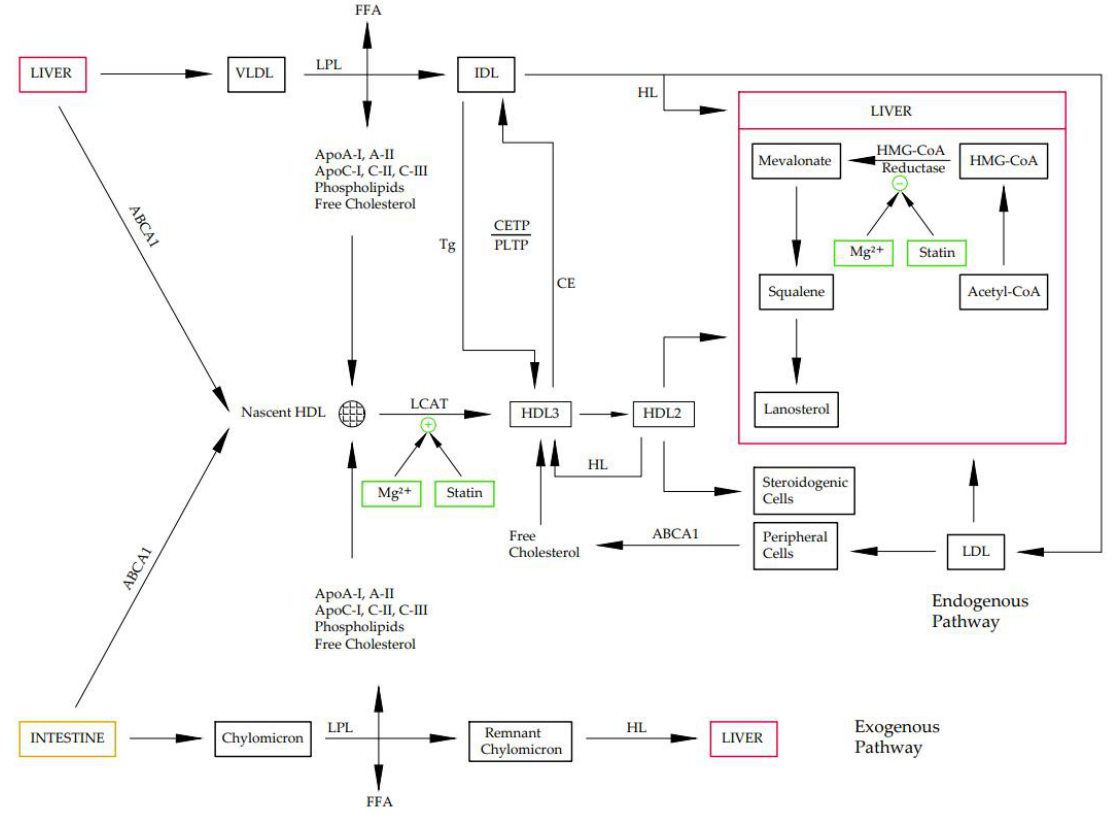
Figure 2. Cholesterol circuit: synthesis, its transport from the peripheral tissues to the liver, and its absorption at the level of intestinal epithelial cells. Abbreviation: ABCA1 = ATP-binding cassette transporter A1; Acetyl-CoA = Acetyl Coenzyme A; Apo = apolipoprotein; ApoA-I = Apolipoprotein A-I; ApoA-II = Apolipoprotein A-II; ApoC-I = Apolipoprotein C-I; ApoC-II = Apolipoprotein C-II; ApoC-III = Apolipoprotein C-III; CE = cholesteryl ester; CETP = cholesteryl ester transfer protein; FFA = free fatty acid; HL = hepatic lipase; HMG-CoA = 3-hydroxy 3-metylglutaryl coenzyme A; IDL = intermediate-density lipoprotein; LCAT = lecithin – cholesterol acyl transferase; LDL = low-density lipoprotein; LPL = lipoprotein lipase. Mg2+ = magnesium ions; PLTP = phospholipid transfer protein; TG = triglyceride; VLDL = very LDL.